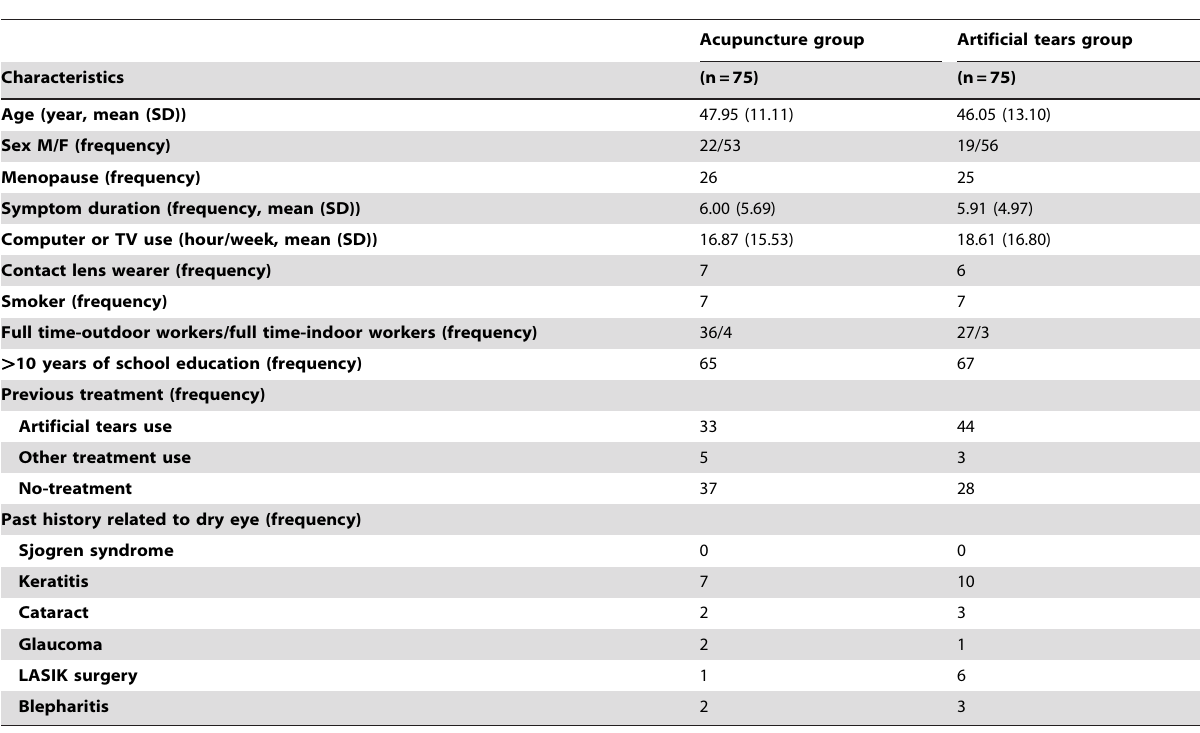
Table 1. Baseline characteristics (intention-to-treat population).